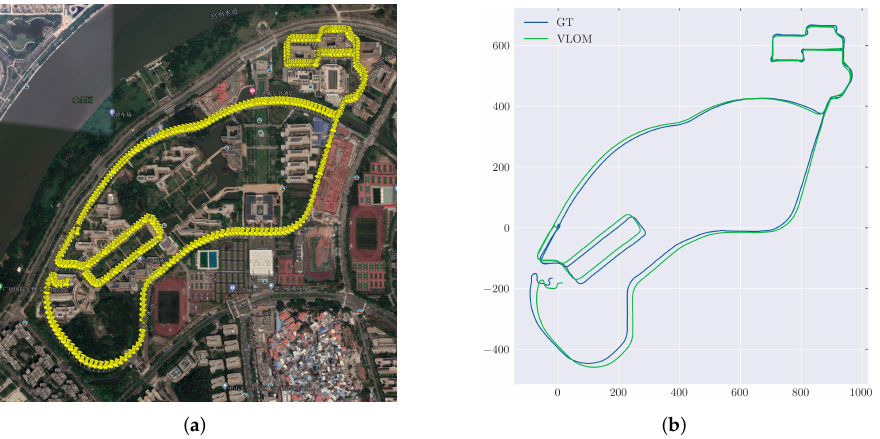
Figure 13. Trajectory of the dataset acquired with RS-LiDAR-M1. ( a ) Ground truth aligned to Google Earth from a top view. ( b ) Comparison of the VLOM trajectory and the ground truth. The results are presented in meters.